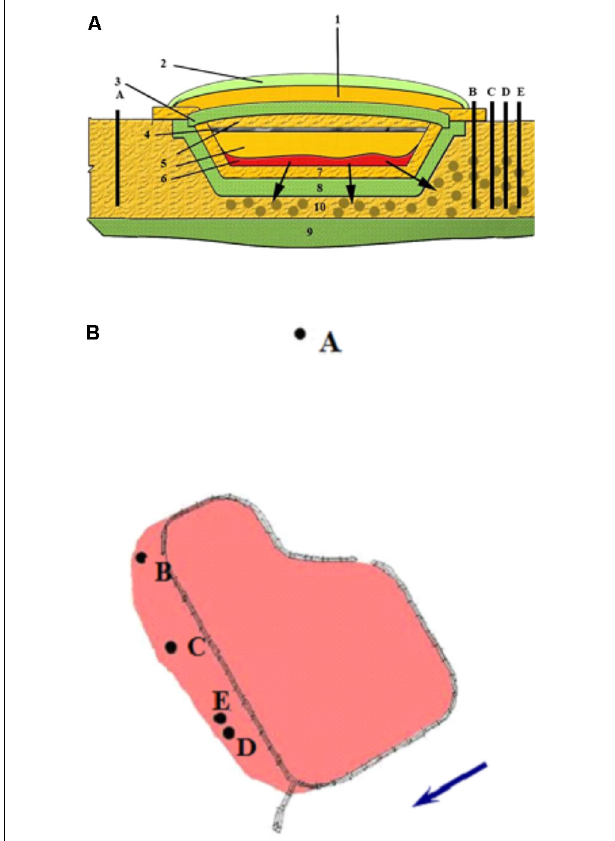
FIGURE 1 | Schematic representation of the suspended surface repository for liquid radioactive waste (A) and location of the observation wells (B) outside the zone of waste spreading (well A) and in the contamination zone (wells B, C, D, and E). The direction of groundwater movement is indicated by an arrow. (1) sandy protective layer; (2) plant layer; (3) upper clay screen; (4) crushed stone; (5) sandy soil; (6) pulp; (7) gravel-sand rammed layer; (8) clay screen; (9) waterproof layer; (10) zone of waste